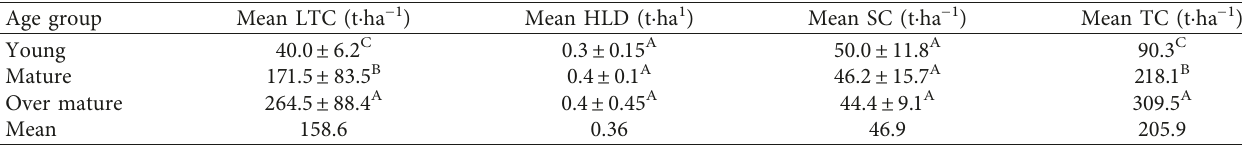
Table 5: Carbon stocks of Chir Pine